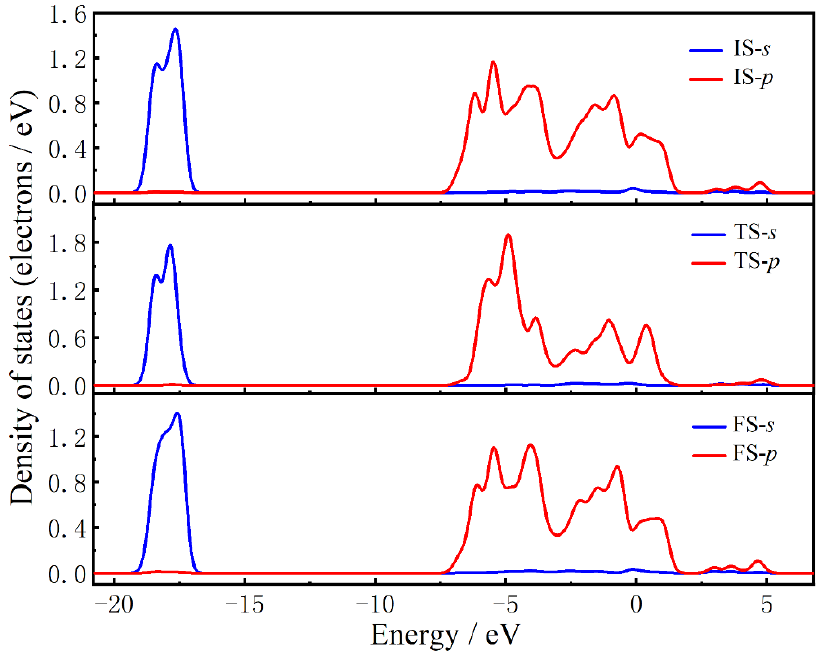
Figure 10. The partial density of states (PDOS) of the O atom during diffusion process in the path 4. Moreover, the energy barriers of the O anion diffusion process are substantially lower than those of the O 2 formation and desorption processes, which could be caused by the O vacancy in CuO. In order to illustrate this, the density of states of the perfect CuO(110) slab and that with an O vacancy were studied. The total density of states (TDOS) and the PDOS of the O atoms are presented in Figure 11. It is observed that the TDOS for the CuO(110) slab with an O vacancy is more flat than that for the perfect CuO(110) slab, suggesting a larger delocalization in the former. In addition, for the perfect CuO(110) slab, the Cu d-orbital is hybridized with the O p-orbital as shown by the state overlap at approximately − 5.84 eV and 0.10 eV, respectively. While the hybridized peaks occur at approximately − 5.70 eV and 0.32 eV in the CuO(110) slab with an O vacancy. As seen from Figure 9, both hybridized peaks shift lower in energy after the formation of an O vacancy, indicating a weaker interaction of Cu with the O atom in the CuO(110) slab with an O vacancy, which facilitates O anion migration. This result may provide an idea for increasing the reactivity of oxygen release, that is, increasing oxygen vacancies. However, the oxygen vacancy creation energy in CuO was calculated to be 7.4 eV. The positive value means that energy is needed to create an oxygen vacancy in CuO.